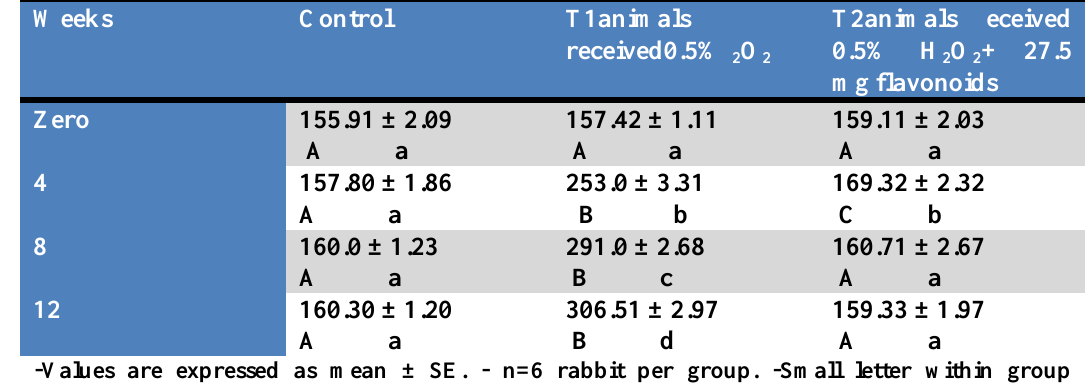
Table (6): Effect of flavonoids extracted from black cumin seeds for twelve weeks on serum total cholesterol (TC) concentration (mg/dl) in control H flavonoids treated adult male rabbit. Weeks